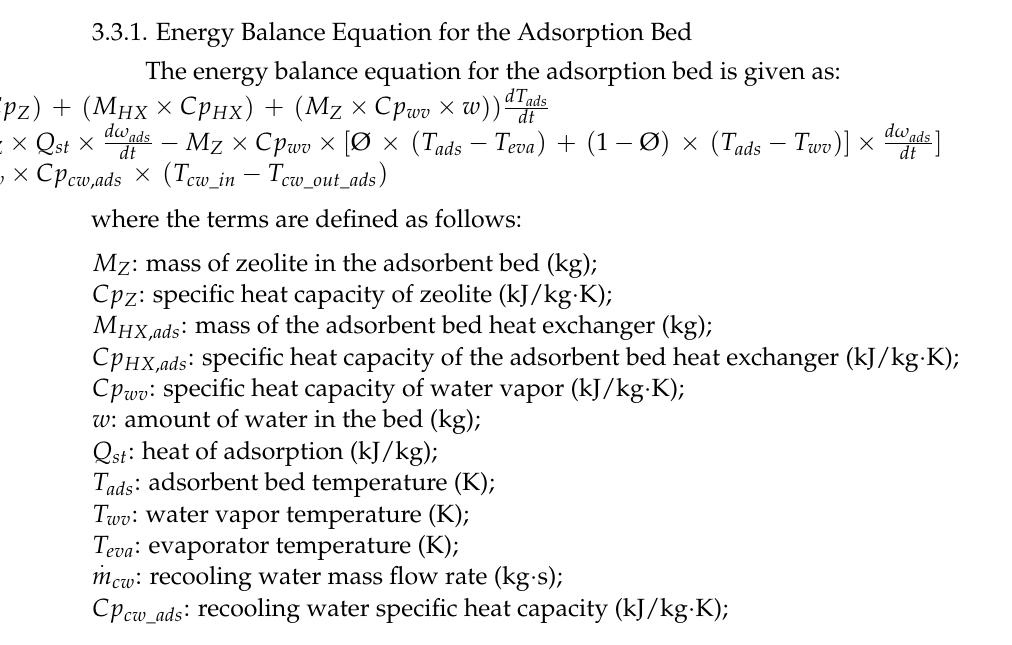
Figure 6. Schematic of chiller with energy flow.